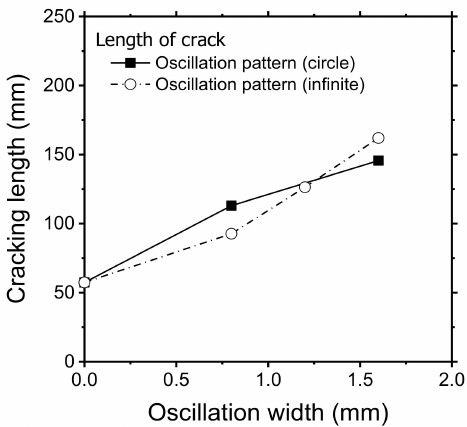
Figure 6. Measured length of the crack from different laser beam scanning patterns and oscillation widths (laser power: 900 W, oscillation frequency: 200 Hz, and welding speed: 3 m/min).